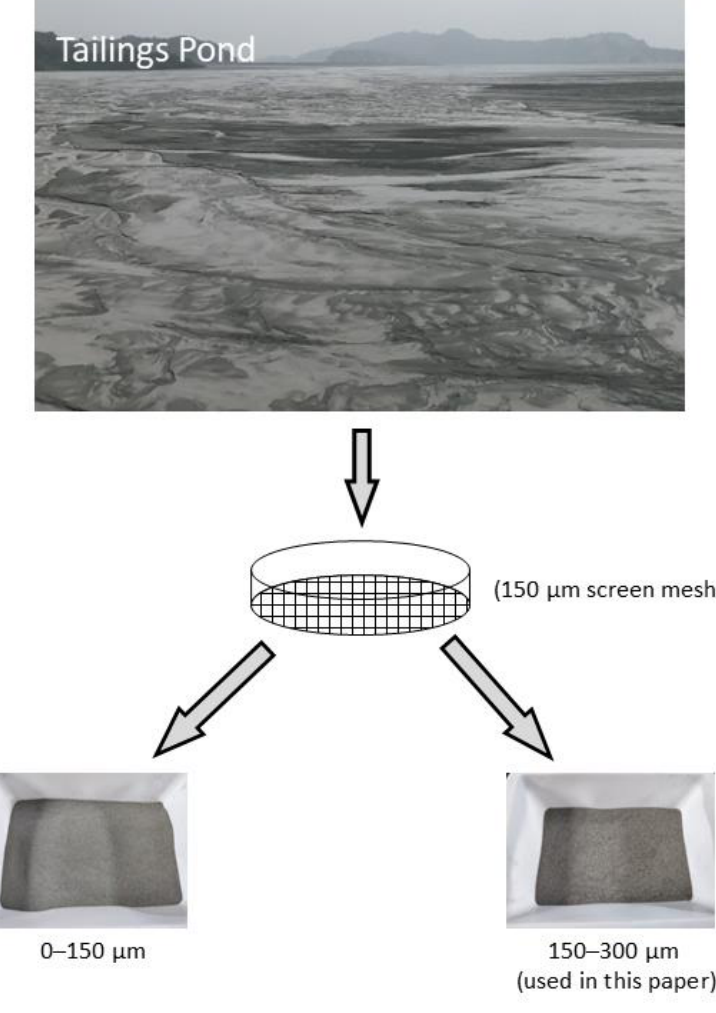
Figure 2. Sieving process of iron tailings.